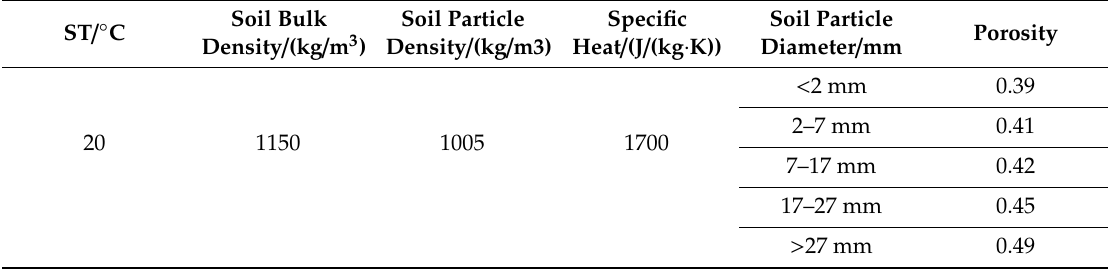
Table 2. Soil physical parameters.